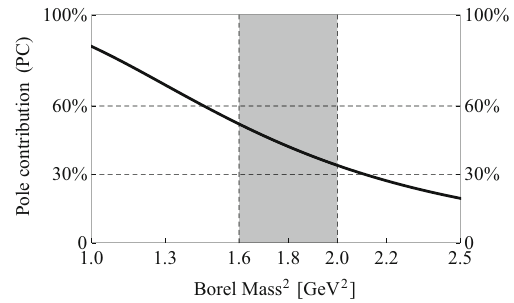
Fig. 3 The pole contribution (PC), defined in Eq. (22), as a function of the Borel mass M B . The curve is obtained by taking s 0 = 6 . 0 GeV 2